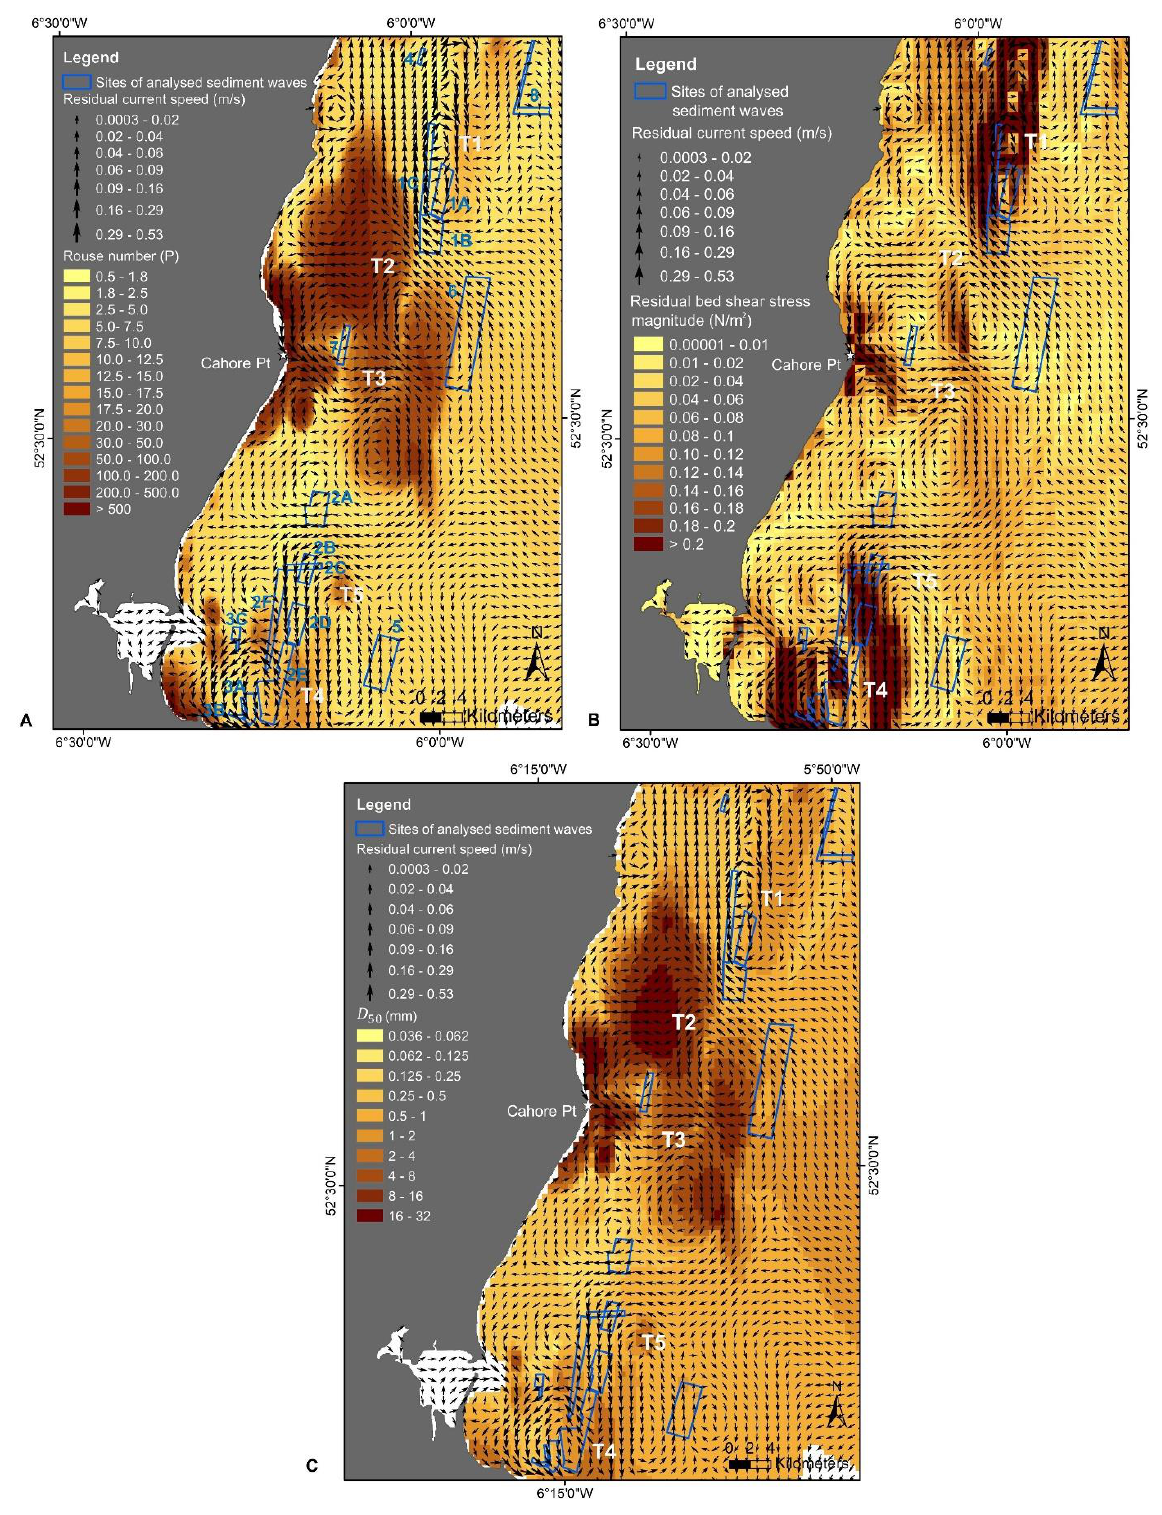
Figure 11. Spatial distribution of ( A ) dimensionless Rouse number, ( B ) residual bed shear stress (N/m²) and ( C ) median grain size ( 𝐷 50 ) overlain by residual current velocity with location of newly analysed sediment wave assemblages. Transition zones (labelled in white as T1 to T5) refer to areas of relatively higher Rouse number, higher residual current velocity, and coarse grain sizes along a residual transport pathway between offshore sand banks and independent sediment wave assemblages.